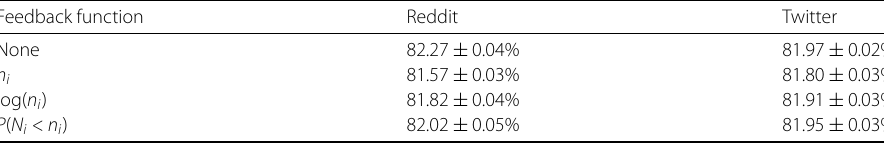
Table 9 The effect of feedback function on the prediction accuracy (the feedback amount x = n i ) Feedback